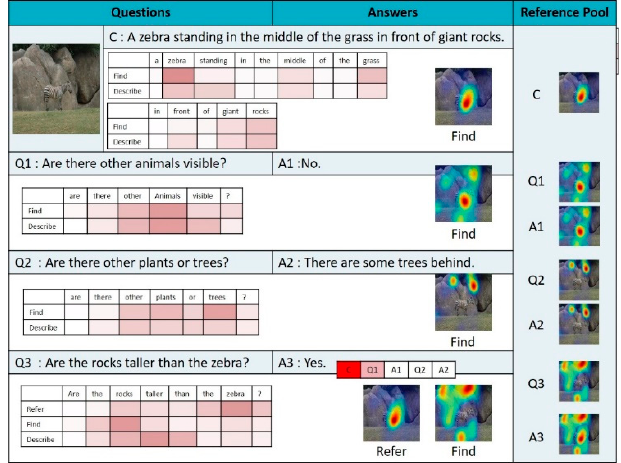
Figure 11. Dialog example 2 derived by the proposed model.